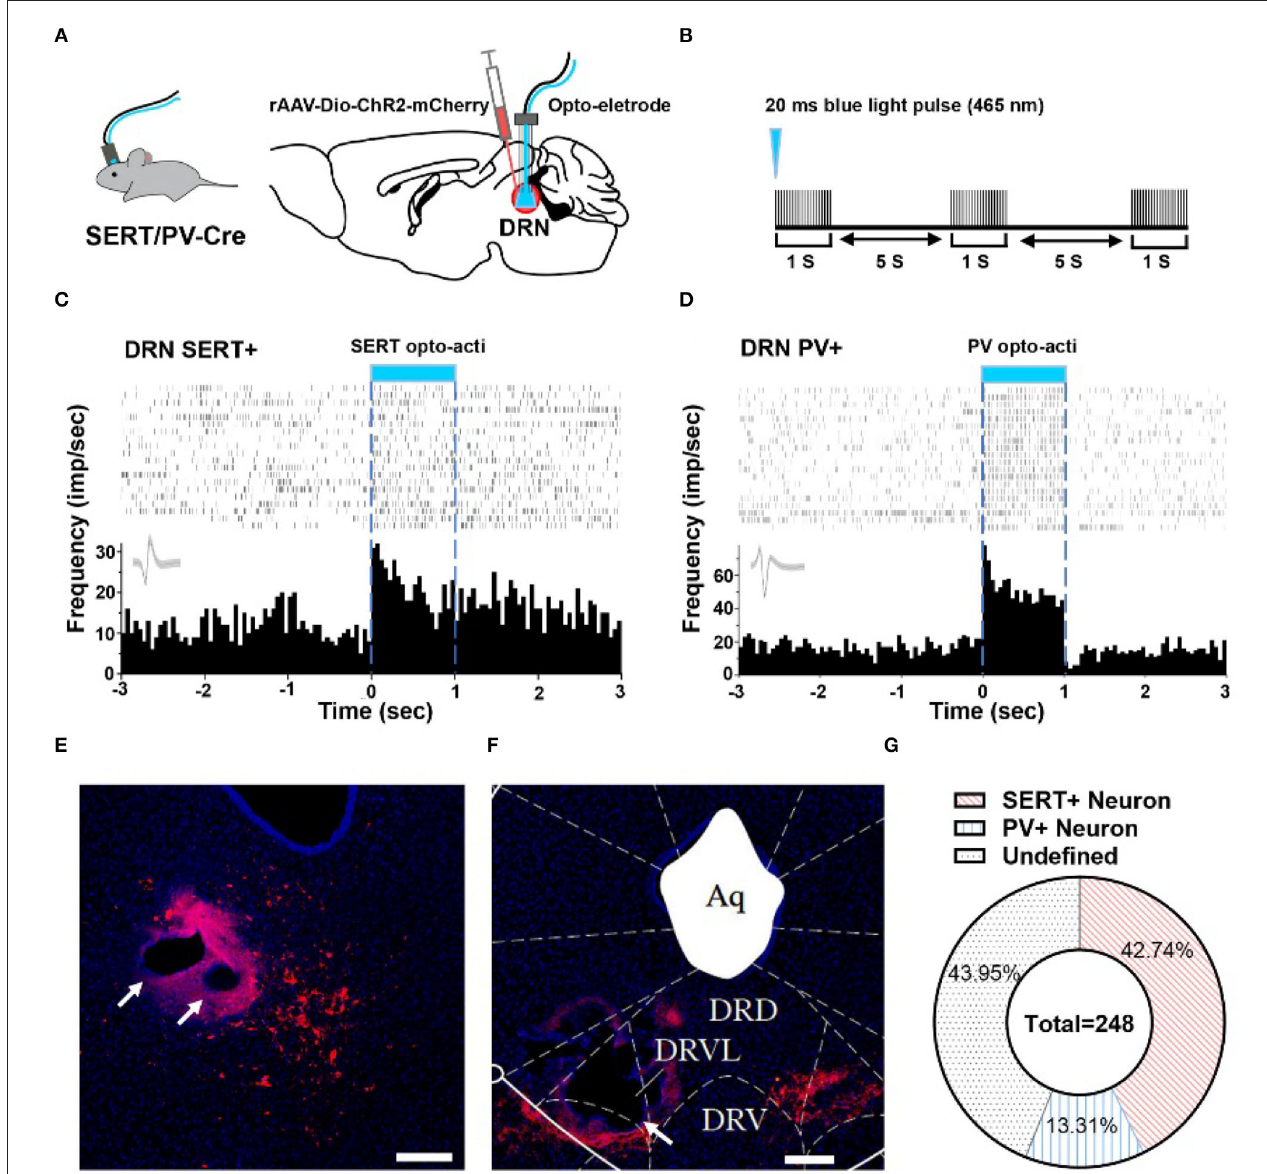
FIGURE 2 | Optogenetic identification of DRN SERT + and PV + neurons. (A) Left: SERT/PV-Cre mice with opto-electrode assembly. Right: injection and stimulation configuration. (B) Using opto to distinguish SERT/PV neurons, Opto tag: 20ms, 20Hz, 10 mW. (C) Optogenetic identification of DRN SERT + neurons based on their responses to optogenetic activation using optrode. (D) Response of PV + neurons during optogenetic activation of DRN PV + neurons. (E) Sample image shows the injection site of DIO-ChR2-mCherry and opto-electrode locations in DRN of SERT-Cre mice. Bar, 200 µ m. (F) Sample image shows the injection site of DIO-ChR2-mCherry and opto-electrode locations in DRN of PV-Cre mice. Bar, 200 µ m. (G) Proportion of different types of neurons recorded in DRN (SERT-Cre mice = 13, 5-HT neurons = 106; PV-Cre mice = 8, PV neurons = 33; undefined neurons =